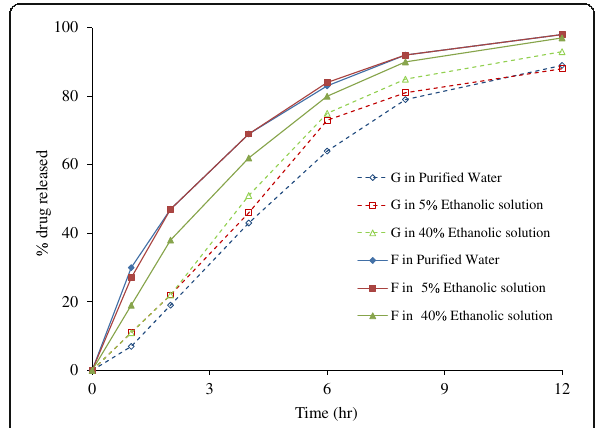
Fig. 21 Effect of alcohol on the kinetic constant (k) and diffusional exponent (n) for HPMC matrices ( R 2 > 0.99) (data from reference (Levina et al. 2007))